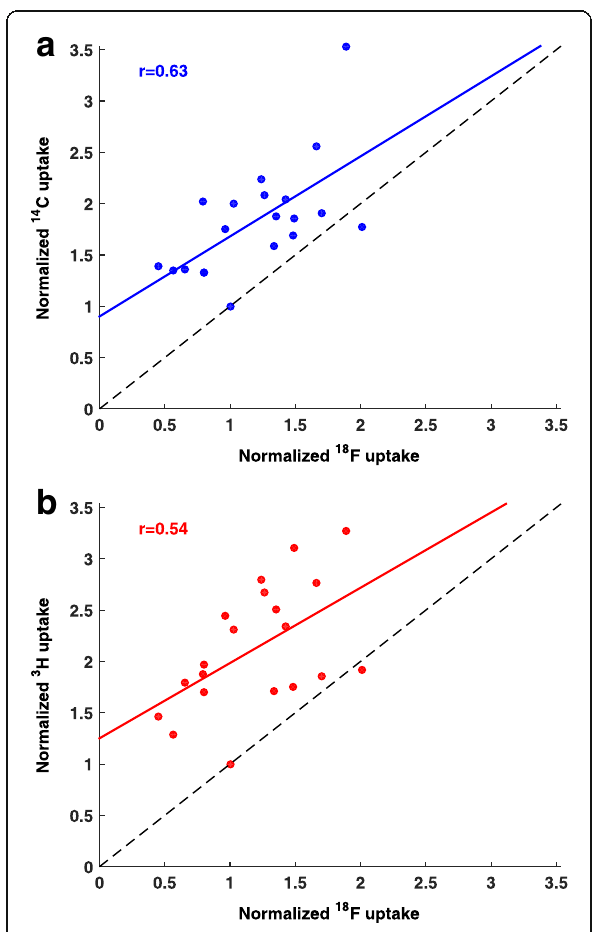
Fig. 2 Whole-tumor correlation between 18 F-fluoromisonidazole and 3 H- or 14 C-evofosfamide. Uptake of 18 F-fluoromisonidazole versus 14 C-evofosfamide ( a ) and 3 H-evofosfamide ( b ). Data from 20 individual mice, normalized to the tumor with lowest evofosfamide uptake. The dashed line has a slope of 1, representing the ideal situation, where tracer and drug behave